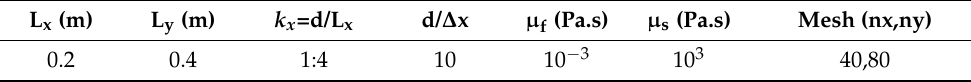
Table A1. Base Scenario.